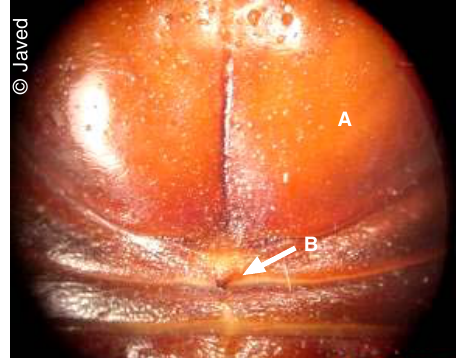
(O)O © Javed Image 8. Ventral view of anterior abdomen of male showing first sternum (A) and Image 7. Lateral view of anal tooth on second sternum segment showing ommatoid